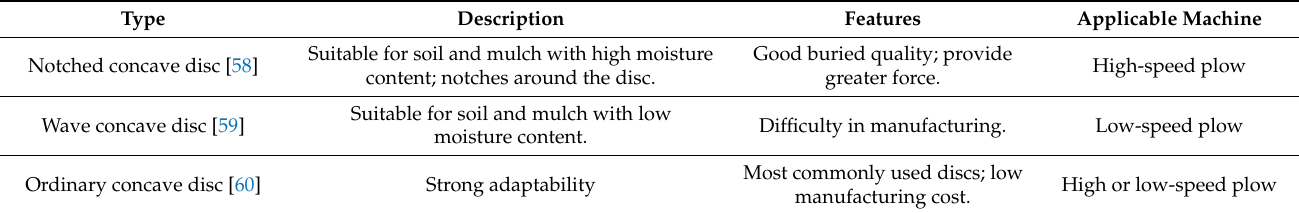
Table 9. Features of different types of